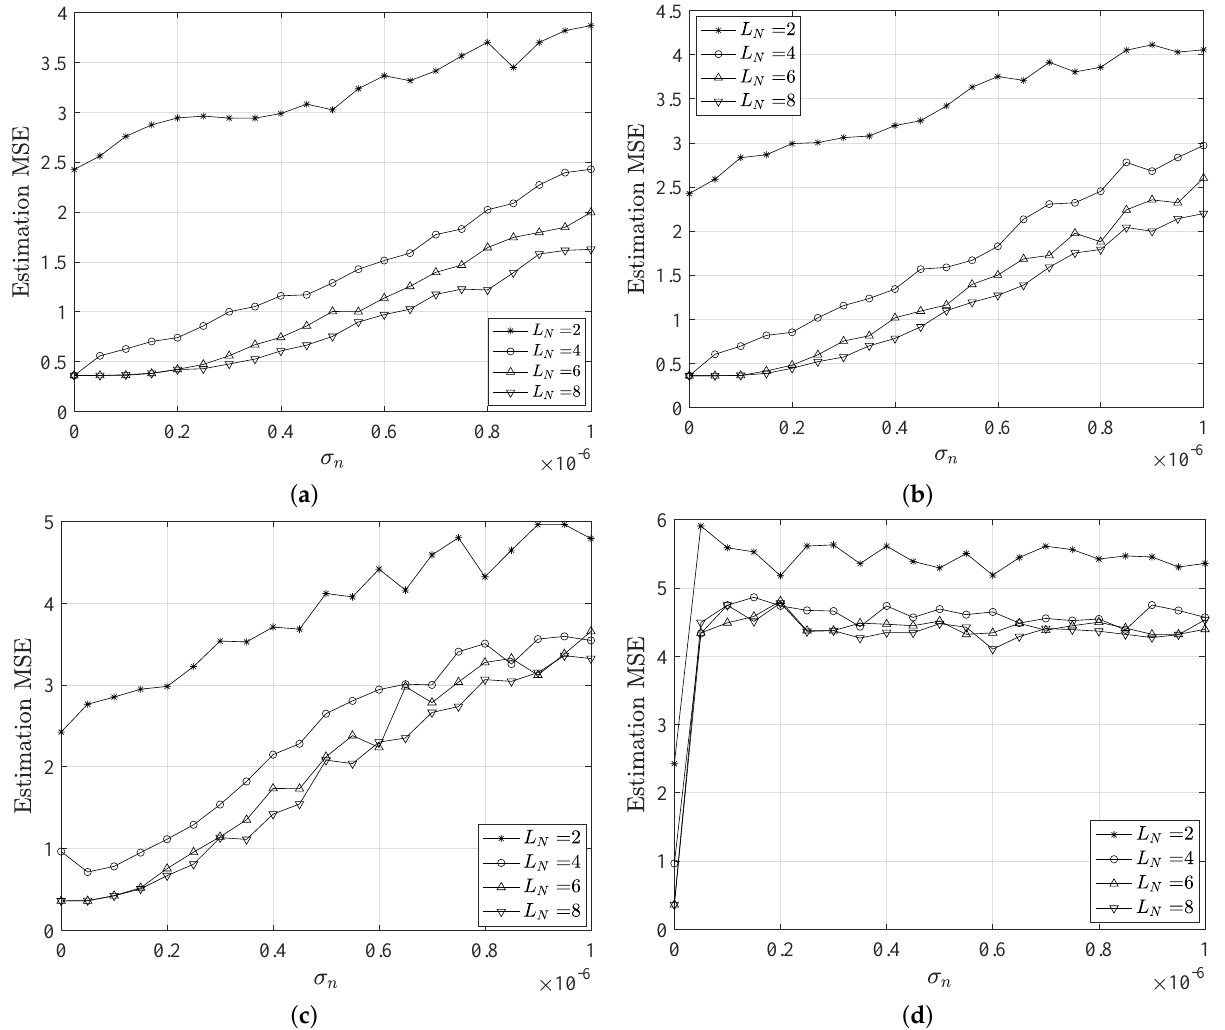
Figure 3. MSE of the position estimation behavior versus the noise standard deviation for different network configurations and water types, i.e., ( a ) pure, ( b ) clear, ( c ) coastal and ( d ) harbor water. We assume a beam angle of 50 ◦